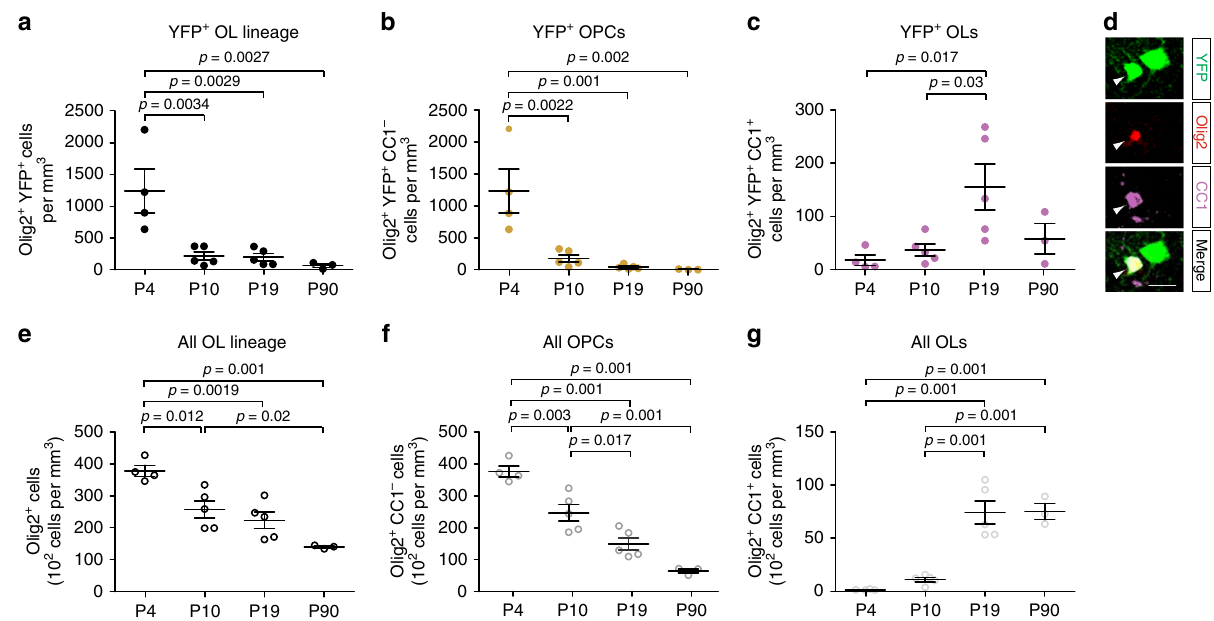
Fig. 3 Surviving Dbx1-derived OPCs become differentiated OLs. a – c Densities of YFP + /Olig2 + cells ( a ), YFP + /Olig2 + /CC1 − OPCs ( b ) and YFP + /Olig2 + / CC1 + OLs ( c ) at PN4, PN10, PN19 and PN90 in the somatosensory cortex of Dbx1 CRE ;Rosa26 YFP mice (dots represent n = 3 to 5 animals per age). Note that YFP + /Olig2 + cell density highly decreases from PN4 to PN10 ( a ). A reduction of YFP + /Olig2 + /CC1 − OPCs ( b ) is followed by an increase in YFP + /Olig2 + / CC1 + OLs ( c ) during development (one-way ANOVA test followed by a Tukey ’ s Multiple Comparison test). d Confocal image of differentiated fi rstOLs at PN19 identi fi ed by the expression of YFP (green), Olig2 (red) and CC1 (magenta). Note the presence of a YFP + /Olig2 − /CC1 − interneuron in close vicinity of this YFP + /Olig2 + /CC1 + OLs (white arrowhead). Scale bar: 20 µ m. e – g Densities of total Olig2 + cells ( e ), Olig2 + /CC1 − OPCs ( f ) and Olig2 + /CC1 + OLs ( g ) at PN4, PN10, PN19 and PN90 in the somatosensory cortex of Dbx1 CRE ;Rosa26 YFP mice (dots represent n = 3 to 5 animals per age). Note that Olig2 + cell density decreases more from PN4 to PN10 than at later stages ( e ). A reduction of Olig2 + /CC1 − OPCs ( f ) is followed by an increase in Olig2 + /CC1 + OLs ( g ) during development (one-way ANOVA test followed by a Tukey ’ s Multiple Comparison test). Data are presented as mean ±